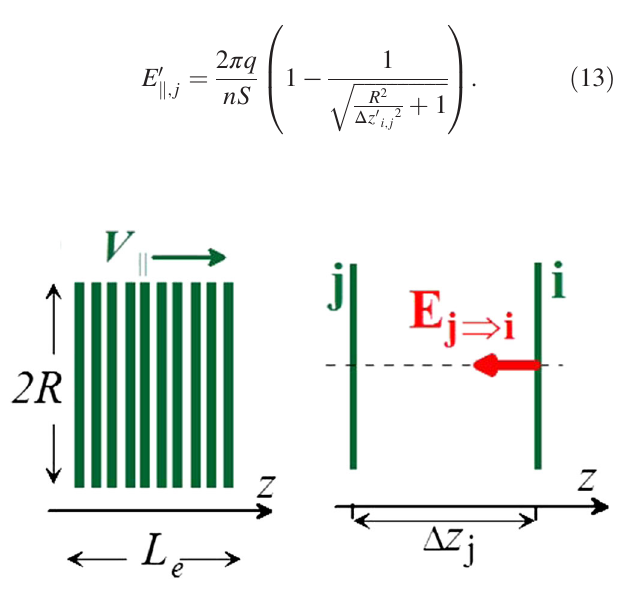
FIG. 6. Calculation of the Coulomb field in the electron bunch: the model of a set of charged